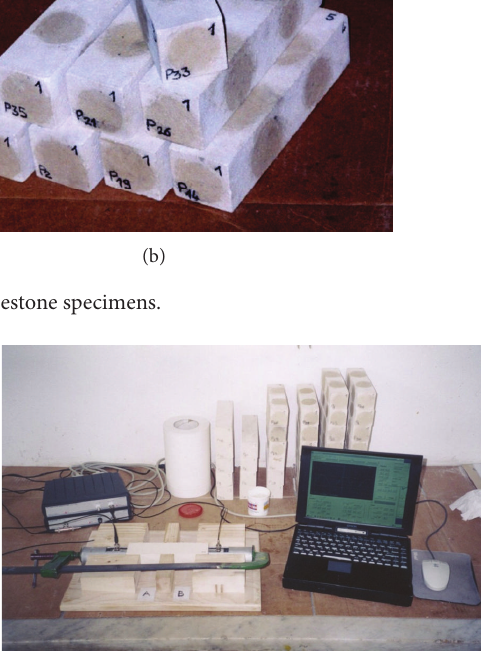
Figure2:UTsetup.(1)PC,(2)oscilloscope,(3)waveformgenerator, ((4), (6)) transducers, and (5) specimen. Figure 3: UT operative